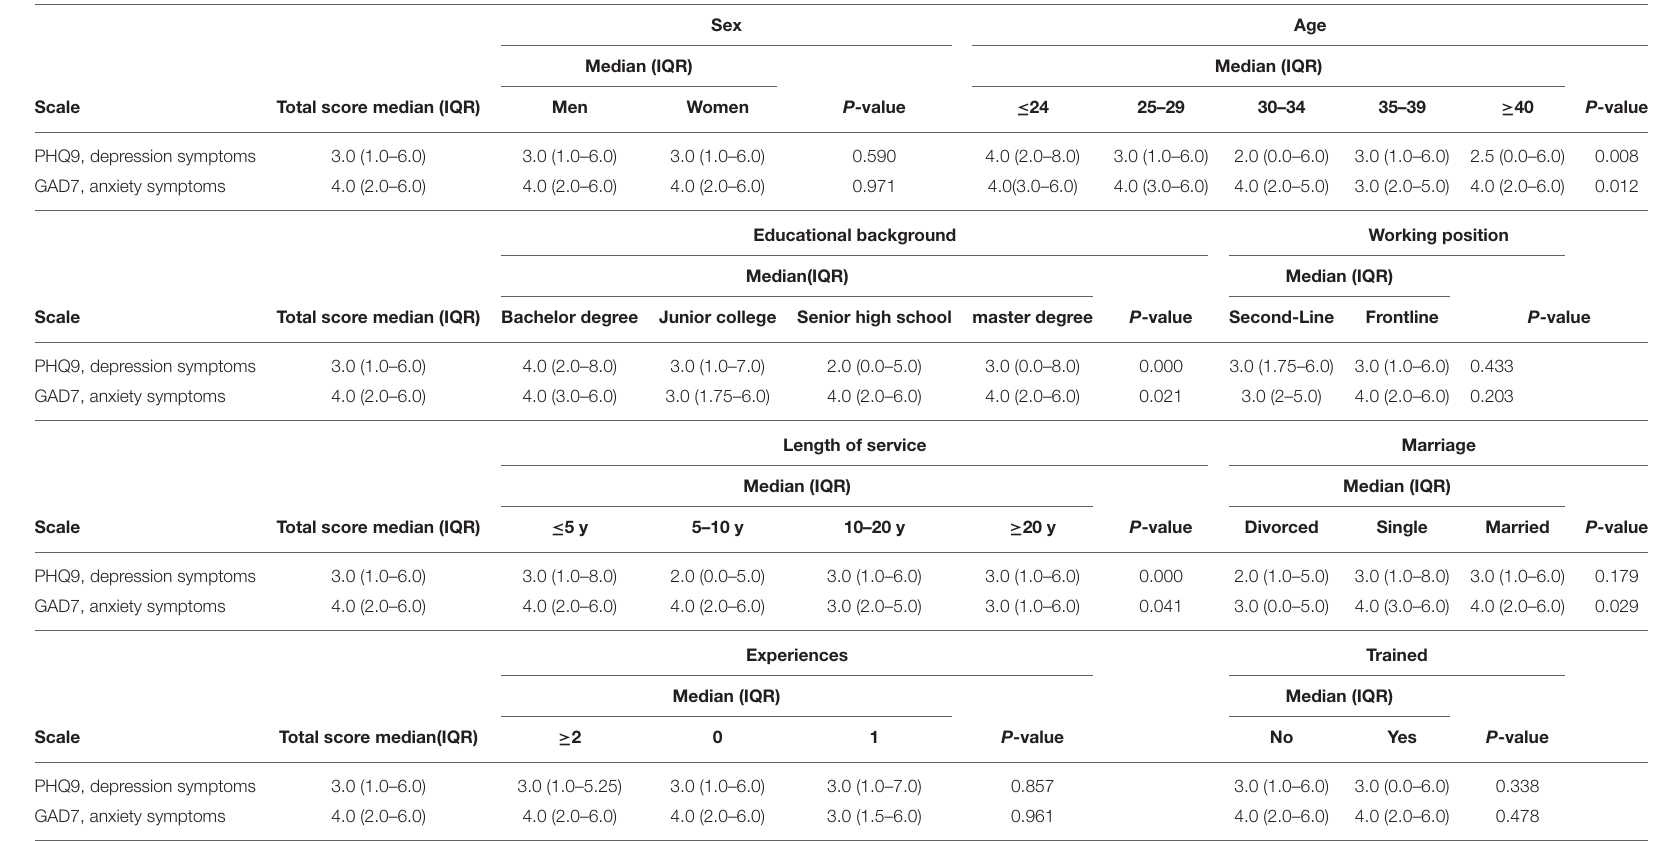
TABLE 3 | Scores of depression and anxiety measurements in the total cohort and